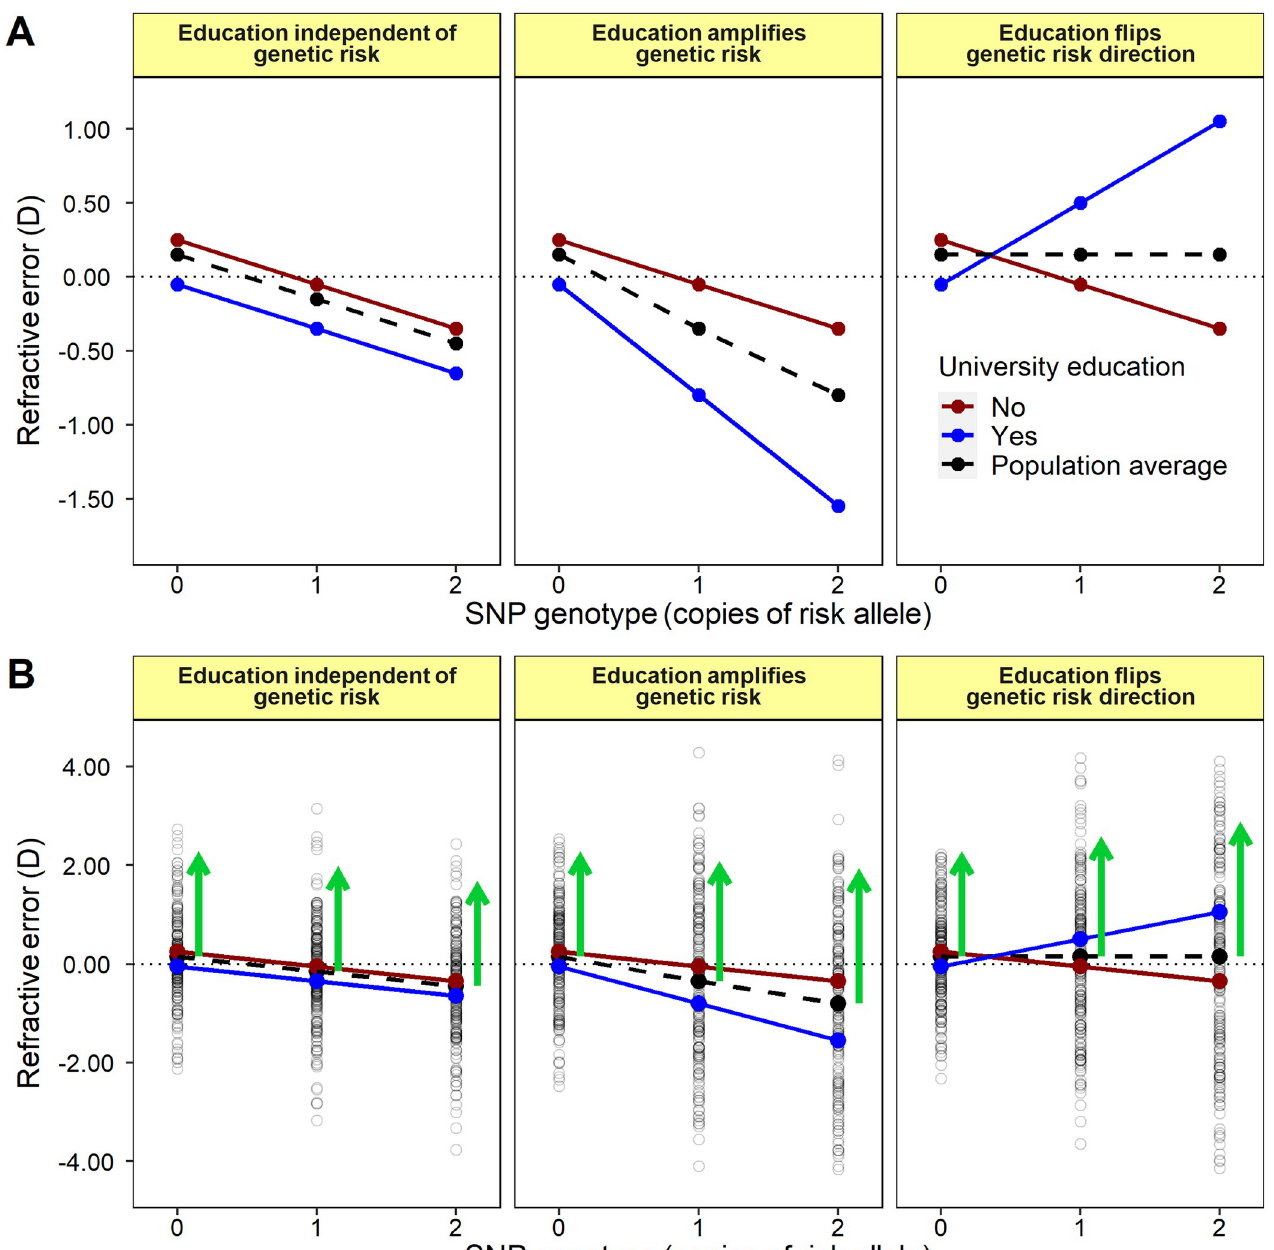
Fig 1. Two-step screening strategy for selecting SNPs likely to be involved in a GxE interaction. The graphs provide schematic illustrations of SNPs without (left) and with (middle and right) GxE interactions, using education as an exemplar environmental exposure. A : Standard GWAS analysis will detect effects averaged across environments for the population (black dashed line). Thus, a standard GWAS analysis will detect SNPs that do not have GxE interaction effects (left panel) but it will also detect SNPs that do have GxE interaction effects (middle panel) unless the SNP effects cancel out in different environments (right panel). B : SNPs involved in GxE interactions are expected to exhibit variance heterogeneity for each genotype, which is depicted as differences in height of the green arrows (middle and right panels) whereas variance heterogeneity is not expected for a SNP with no GxE interaction (left